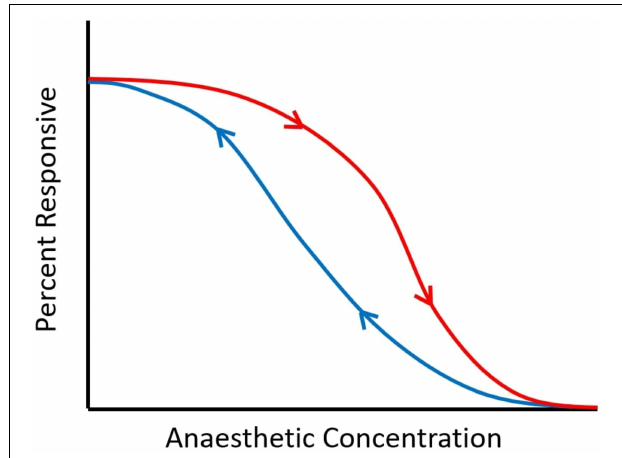
FIGURE 2 | Schematic of neural inertia. As anaesthetic dose is increased, responsiveness is diminished. However, the dose at which a certain proportion of responses is observed is not the same for induction (downward arrow, in red) and emergence (upward arrow, in blue), indicating path-dependence (hysteresis). Between the two curves, subjects may be awake or anaesthetised, depending on whether the drug concentration is being increased or decreased. The wider the gap between the two curves, the greater the